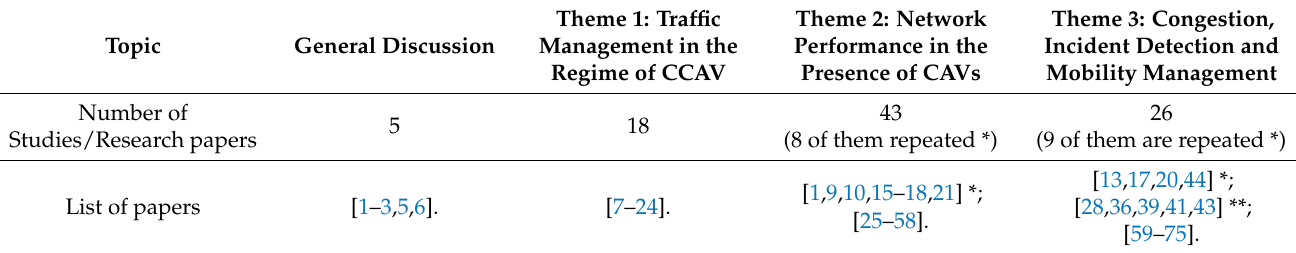
Figure 1. Flowchart of the systematic review using the PRISMA guidelines. Table 1. Systematic classification of studies considered under each of the themes.